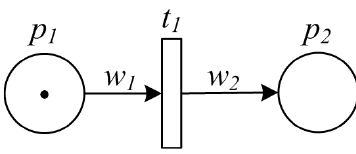
Figure 2. PPN model of sequence pattern.